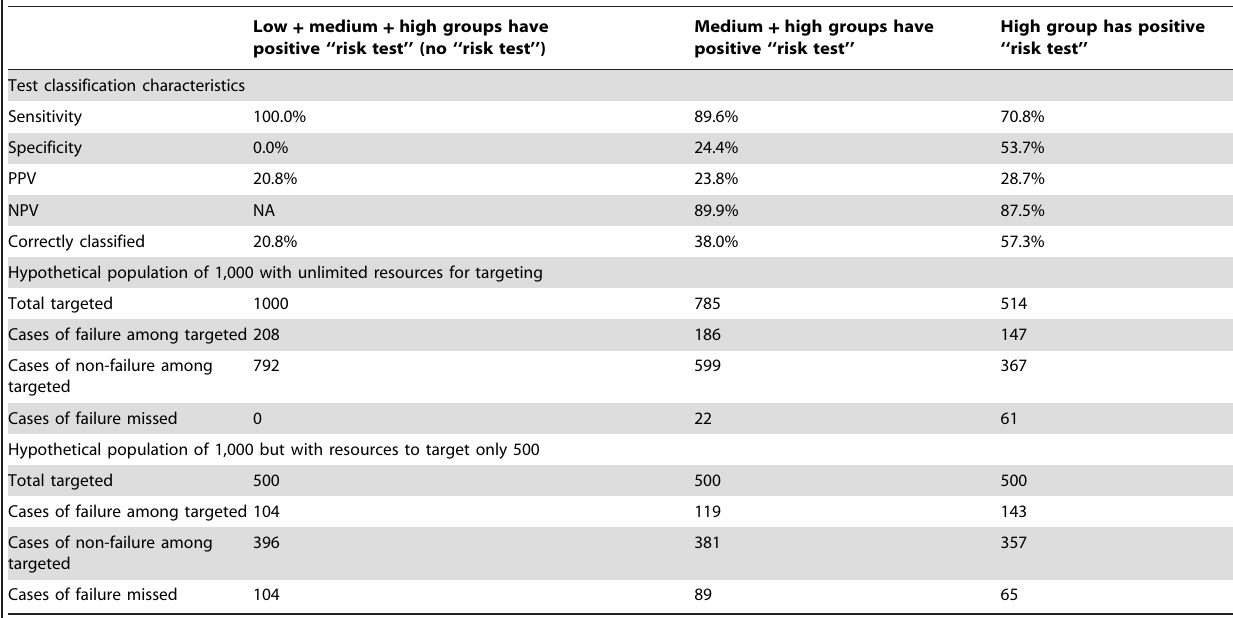
Table 6. Diagnostic ‘‘Risk Test’’ Characteristics under Different Strategies.